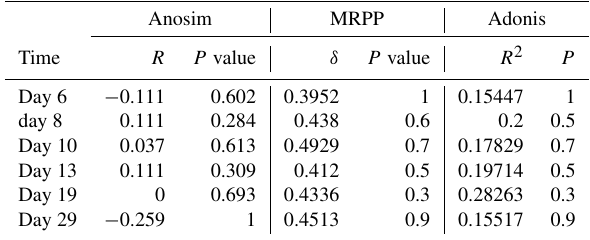
Table 2. Dissimilarity tests of bacterial communities in the HC and LC treatments at various time